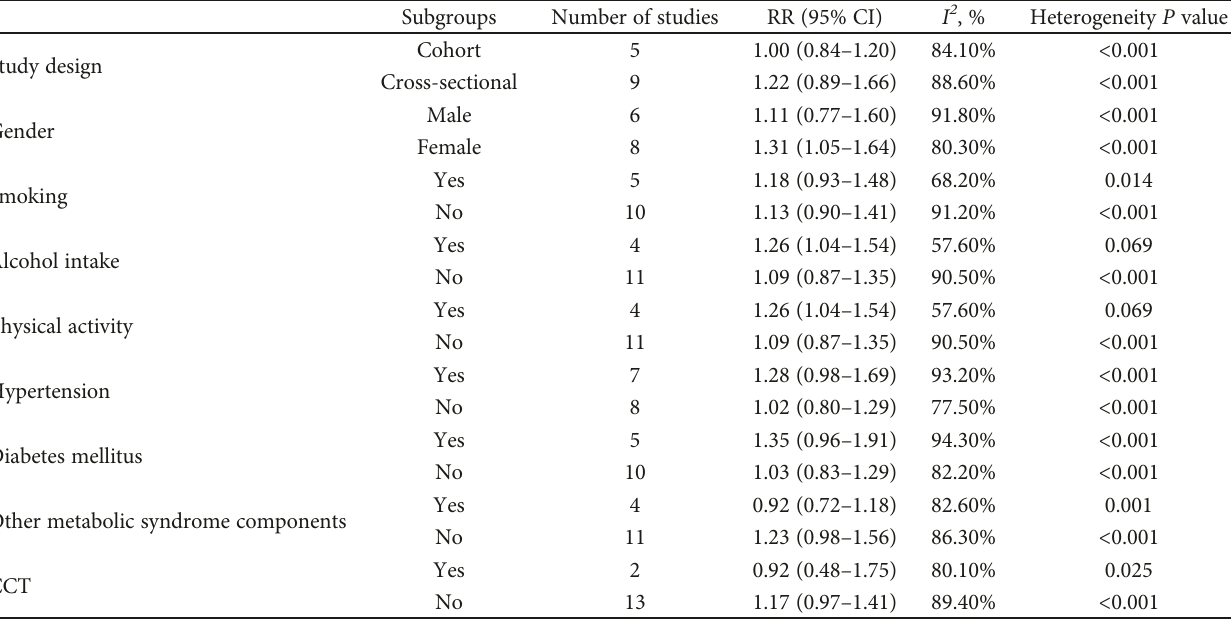
Table 3: Results of subgroup analysis between adiposity and glaucoma with pooled RR.